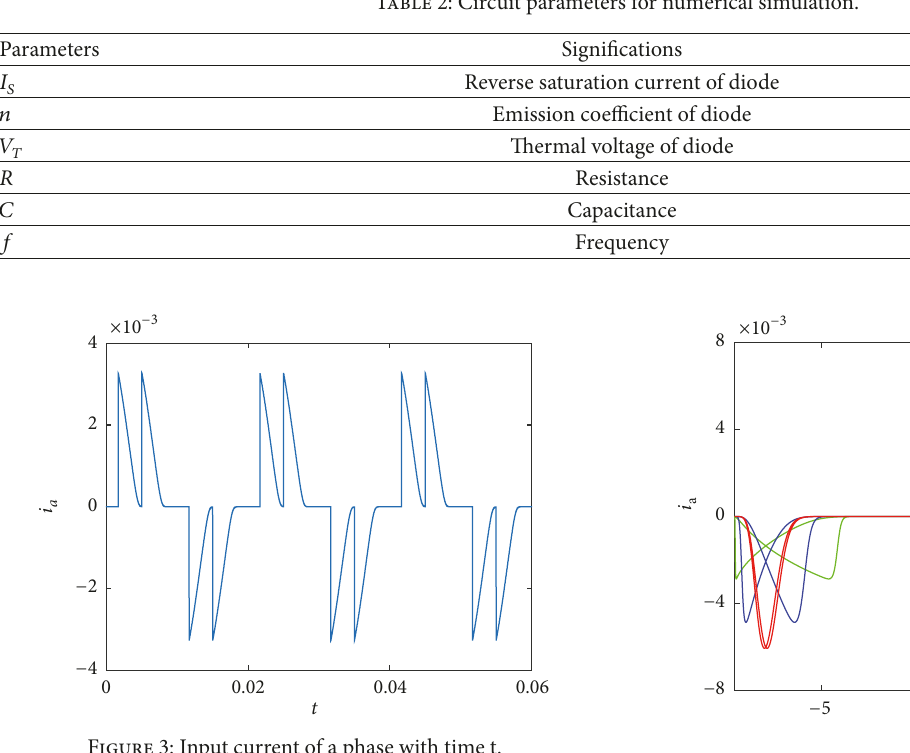
Figure 3: Input current of a phase with time t.